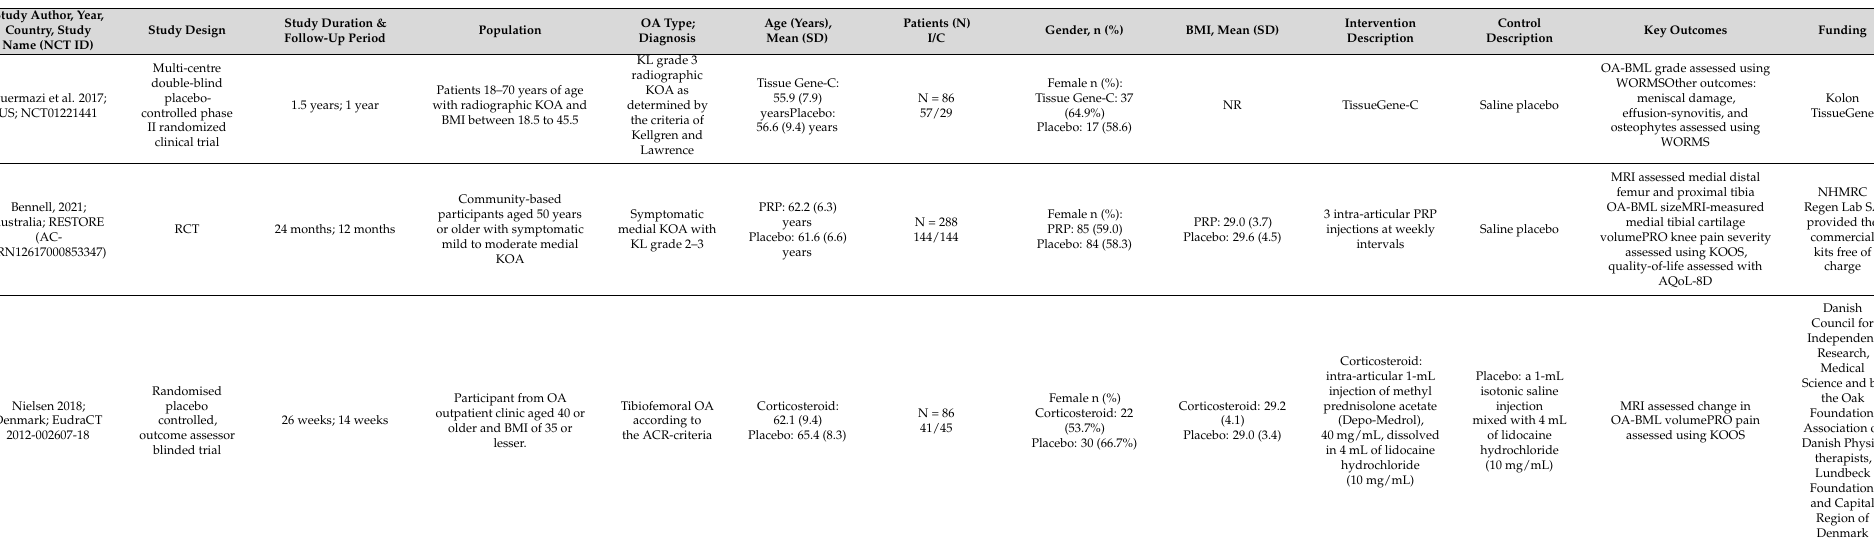
ACR: American College of Rheumatology classification criteria; APS: autologous protein solution; AQoL-8D: Assessment of Quality of Life–8 Dimension score; BME: Bone marrow edema; CGI-S: Clinical Global Impression of Severity; CGI-S/C: Clinical Global Impression of Severity/Change; cMFTC: Central Medial Femorotibial Compartment; KL grade: Kellgren-Lawrence grading scale; C: Control arm; I: Intervention arm; ICRS criteria: International Cartilage Repair Society; KOA: knee osteoarthritis; KOOS: Knee Injury, and Osteoarthritis Outcome Score; LR-PRP: Leukocyte Rich-Platelet-rich Plasma; MOAKS: MRI Osteoarthritis Knee Score; NIAMS: National Institute for Arthritis and Musculoskeletal Disorders and Skin Diseases; NR: not reported; OA-BML: bone marrow lesion; OMERACT-OARSI: Outcome Measures in Rheumatology–Osteoarthritis Research Society International; PGI-S/C, Patient Global Impression of Severity/Change; PRO: Patient Reported Outcomes; PRP: Platelet-rich Plasma; RCT: Randomized Controlled Trial; SF-36: 36-Item Short Form Health Survey; VAS: Visual Analogue Scale; WOMAC: Western Ontario and McMaster Universities Osteoarthritis Index; WORMS: Whole Organ Magnetic Resonance Imaging